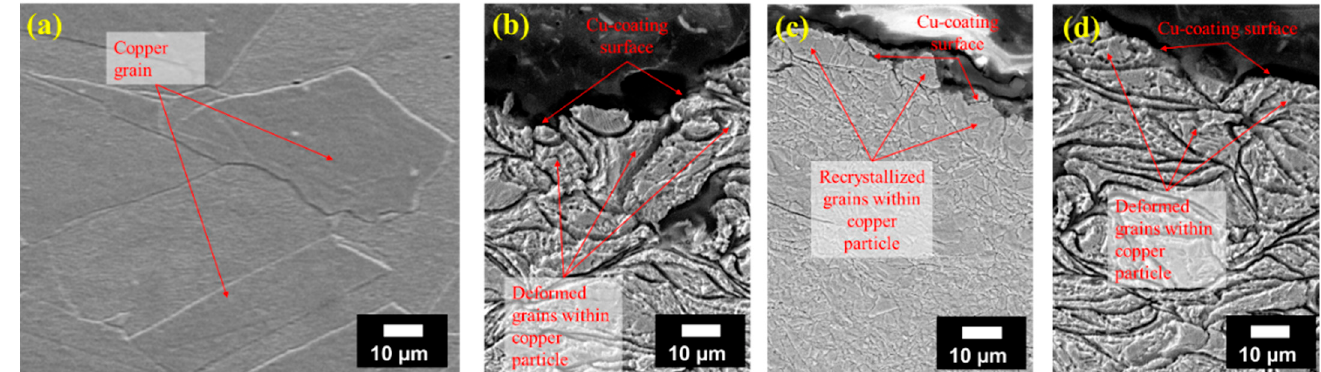
Figure 10. SEM images showing the microstructures of ( a ) bulk Cu, and near ‐ surface coatings of ( b ) Cu/SS ‐ AD, ( c ) Cu/SS ‐ HT, and ( d ) Cu/Al ‐ AD.